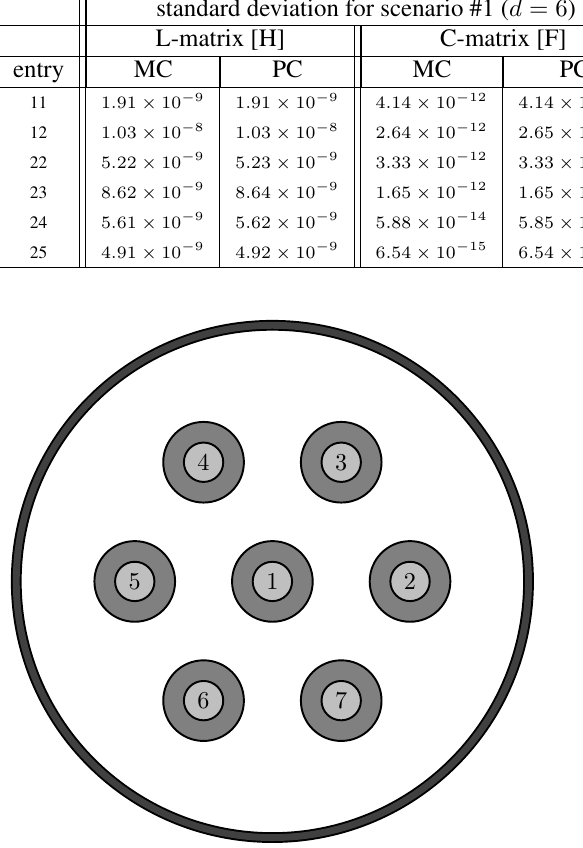
Table 3: Standard deviations of the p.u.l. inductance and capacitance matrix entries for the shielded cable of Fig. 4. standard deviation for scenario #1 ( d = 6 )